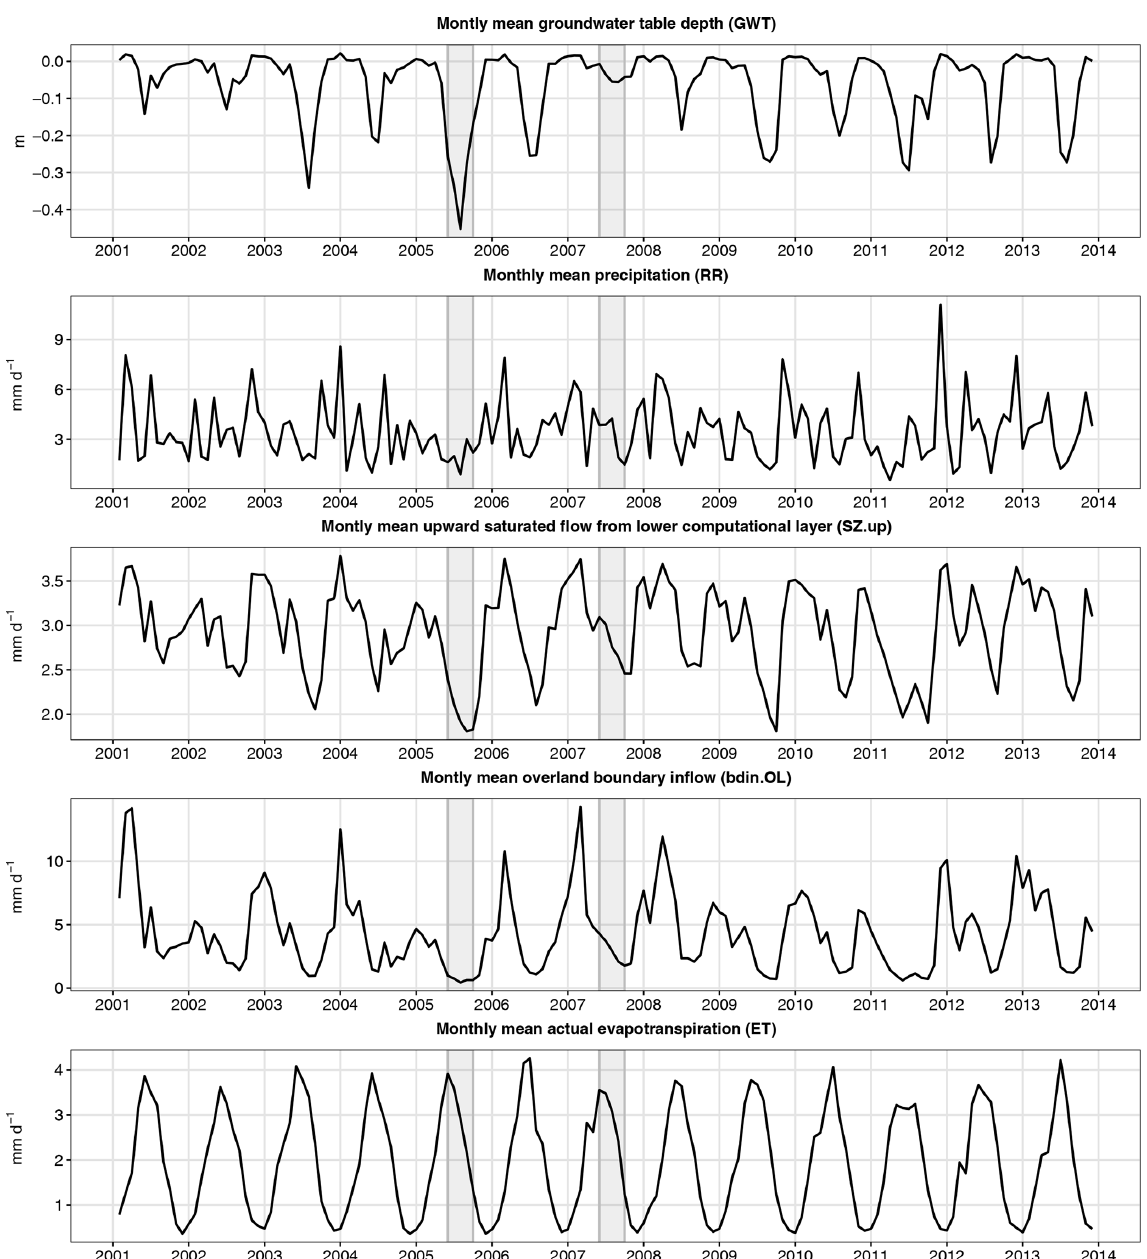
Figure 12. Monthly means of simulated groundwater table depth and selected water balance items in the peat soil domain (2001–2013). Grey bands highlight two contrasting summers further described in Sect.